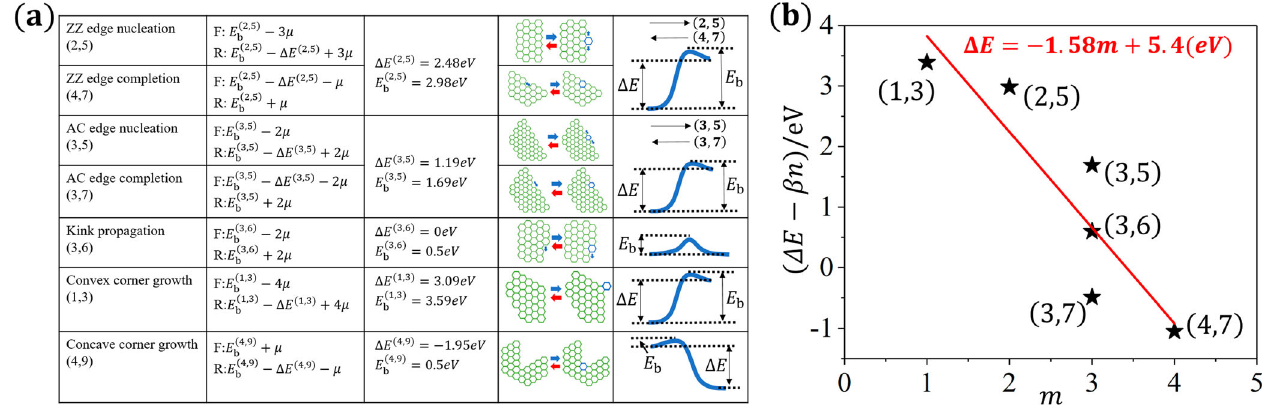
Fig. 2 Key events and corresponding reaction barriers. a List of some key events and the calculated reaction energies and the estimated reaction barriers. The fi rst column lists the types of atomic steps and corresponding forward event indices ( m , n ). The second column is Gibbs free-energy barrier of forward (F) and reverse (R) reactions. In the third column, we list the calculated reaction energy and estimated barriers of these events on a Pt(111) surface. In the fourth column, we show local structure of these events, where blue and red arrows indicate forward and reverse reactions, respectively. In the fi fth column, we sketch the reactions, where the reaction energies Δ E and barriers E b of them are also shown. b Linear fi tting of reaction energy (after taking β = 0.1 eV) with number of nearest neighbors m